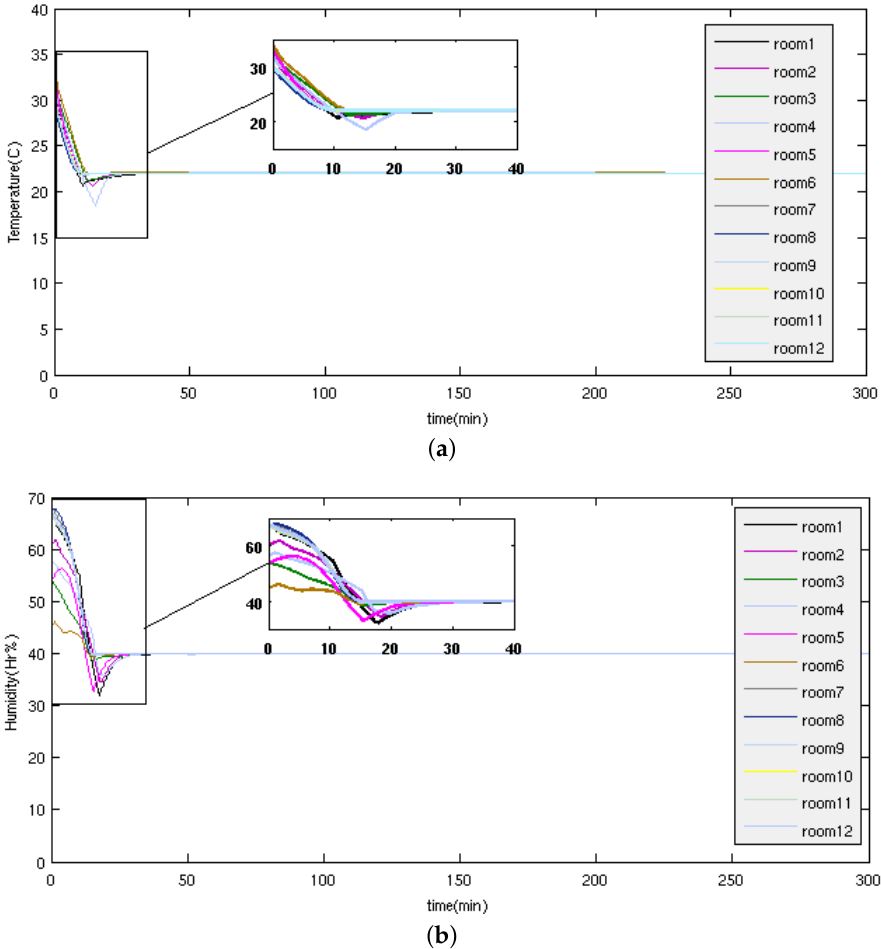
Figure 10. The numerical simulation; colored lines represent Rooms 1 to 12. ( a ) Simulation results of the fuzzy control of room air temperature with temperature disturbances and 50% packet loss. The time evolution of temperature in time for each room. ( b ) Simulation results of fuzzy control of room air humidity with temperature disturbances and 50% packet loss. The variation of humidity (RH) in time for each room. The response in both cases includes 50% packet loss on the network and also in the presence of